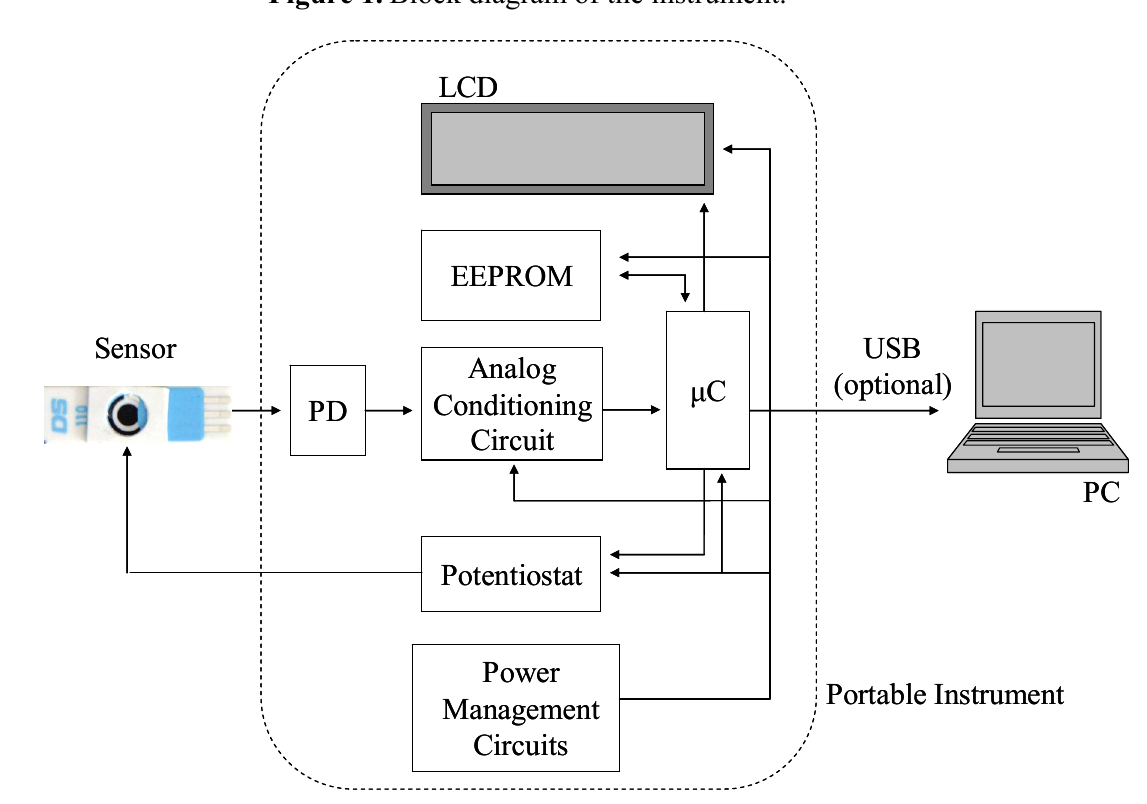
Figure 1. Block diagram of the